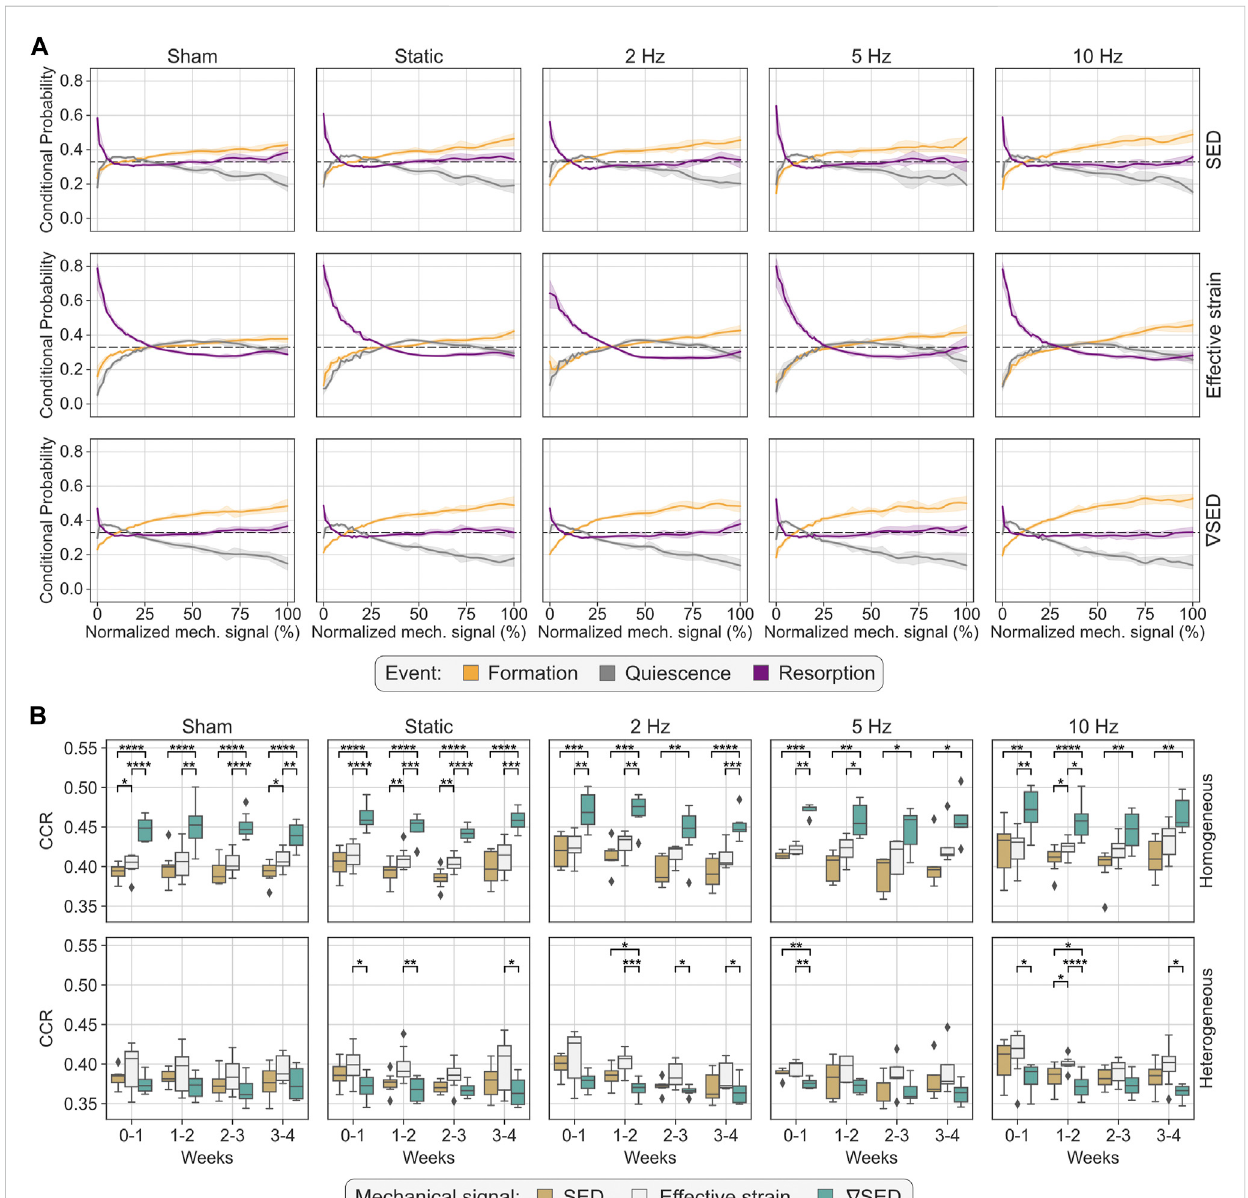
FIGURE 2 Quanti fi cation of mechanoregulation information from time-lapsed in vivo micro-CT image data. (A) Conditional probability curves connecting the mechanical environment with (re)modeling events, computed for all groups and mechanical signal descriptors considered (SED, effective strain, and ∇ SED), using homogeneous material properties. The plots show the mean probability line per group after applying a LOWESS operation for the interval 0 – 4 weeks and its corresponding 95% con fi dence interval. The dashed line at 0.33 identi fi es the probability of a random event for a ternary classi fi cation case. (B) Comparison of correct classi fi cation rate (CCR) values obtained by SED, effective strain, and ∇ SED as local mechanical signal descriptorscomputed from micro-FE with homogeneousor heterogeneousmaterial properties. Higher CCR values indicate higher sensitivityto retrieve mechanoregulation information. Similar to (A) , the analysis also considers the interval of 0 – 4 weeks. Statistical signi fi cance was determined by the Conover-Iman test, corrected for multiple comparisons by the Holm-Bonferroni method. Statistical signi fi cance legend: * p < 0.05, ** p < 0.01, *** p < 0.001, **** p <